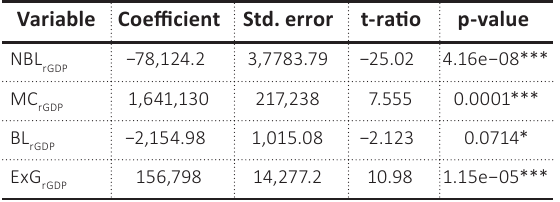
Table 4. Regression outputs